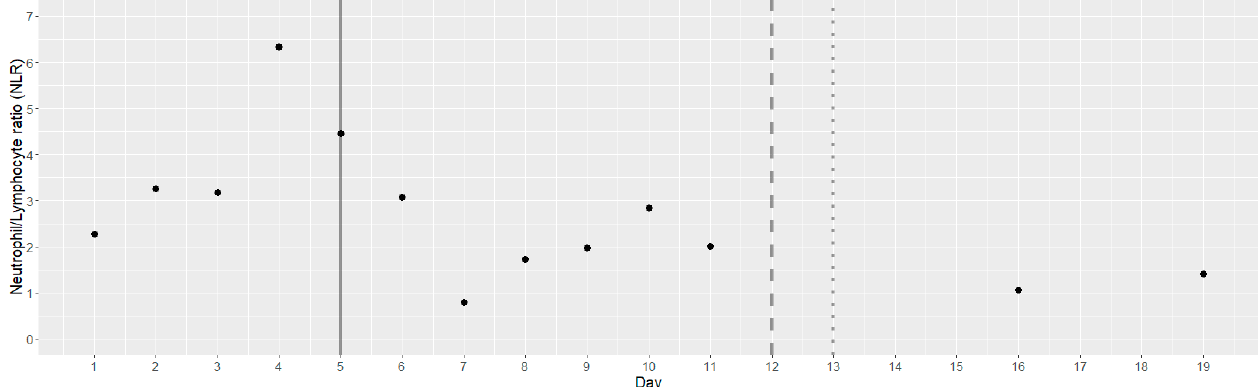
Figure 5. Neutrophil/Lymphocyte Ratio (NLR) throughout the hospitalization period. The solid line denotes transfer to PICU + intubation, the dashed line denotes extubation, and the dotted line denotes discharge from PICU.